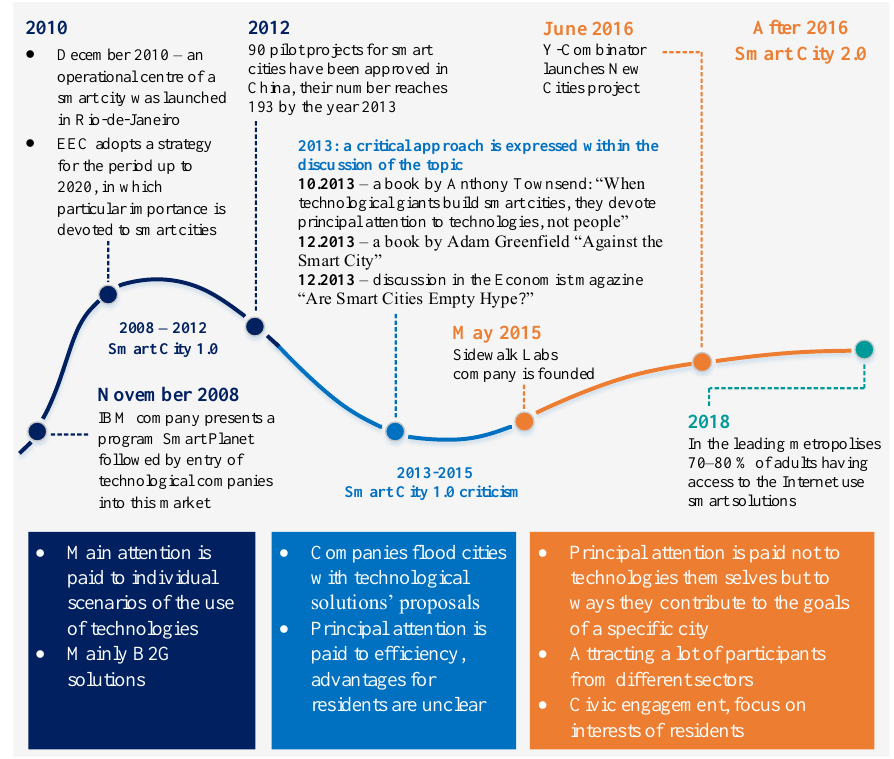
Fig. 2. Environmental protection management technologies as a smart city element (methods and procedures)